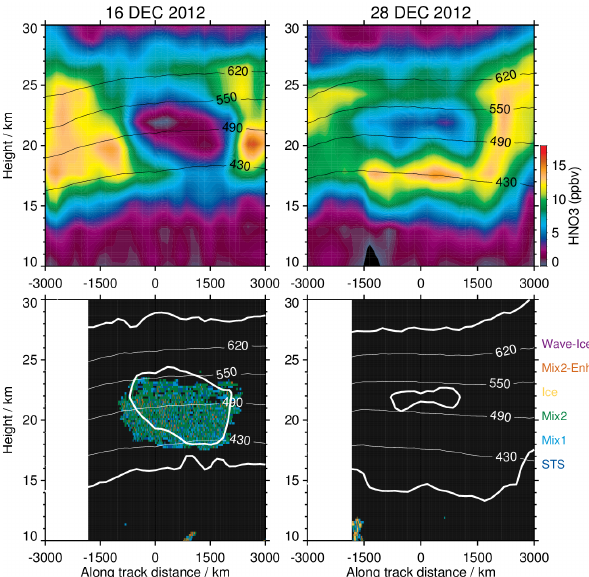
Figure 10. MLS HNO 3 (color bar range 0 to 18ppbv) along an orbit track (top panels) and co-located CALIPSO PSC classification (bot- tom panels, see text) on 16 and 28 December 2012. The orbit tracks shown on each day are very close to the same position and orienta- tion, extending over Iceland approximately parallel to the eastern- most part of the Greenland coast. The zero point on the tracks is at the turnaround of the orbit, that is, the point closest to the pole. Overlaid labeled lines are potential temperature contours. Overlaid thick white contour in the bottom panels is the 5ppbv HNO 3 con-